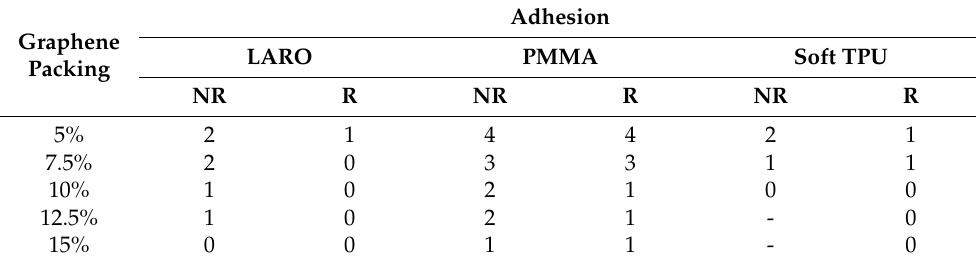
Table 3. Adhesion of the printed paths to the flexible PET